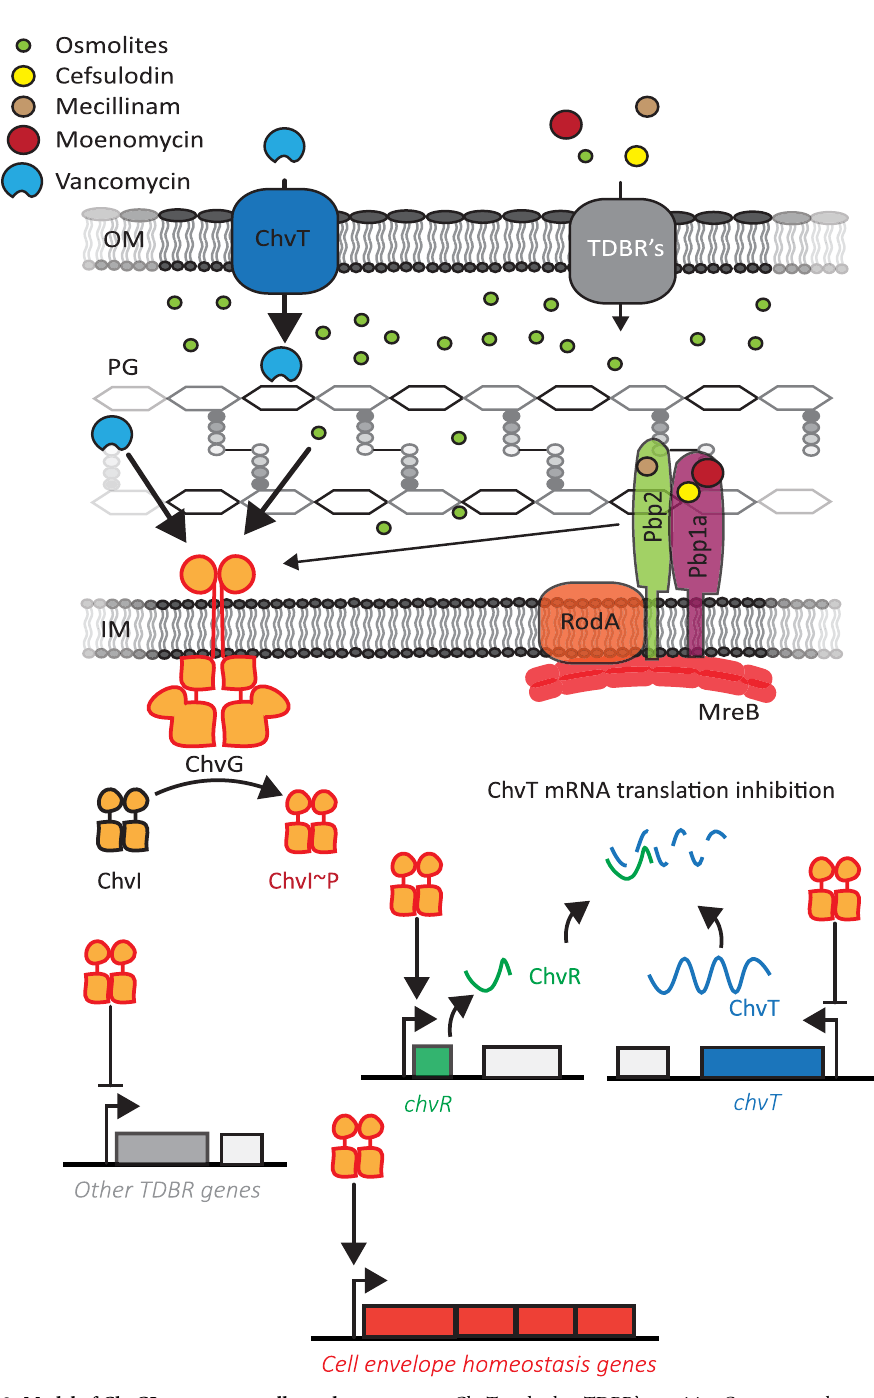
Fig 8. Model of ChvGI response to cell-envelope stressors. ChvT and other TDBR’s sensitize C . crescentus by transporting antibiotics targeting PG transpeptidation and osmolytes into the periplasm. Then, the HK ChvG autophosphorylates and activates the RR ChvI to upregulate the expression of genes related to cell envelope homeostasis and down-regulate outer membrane transport (such as TDBR).